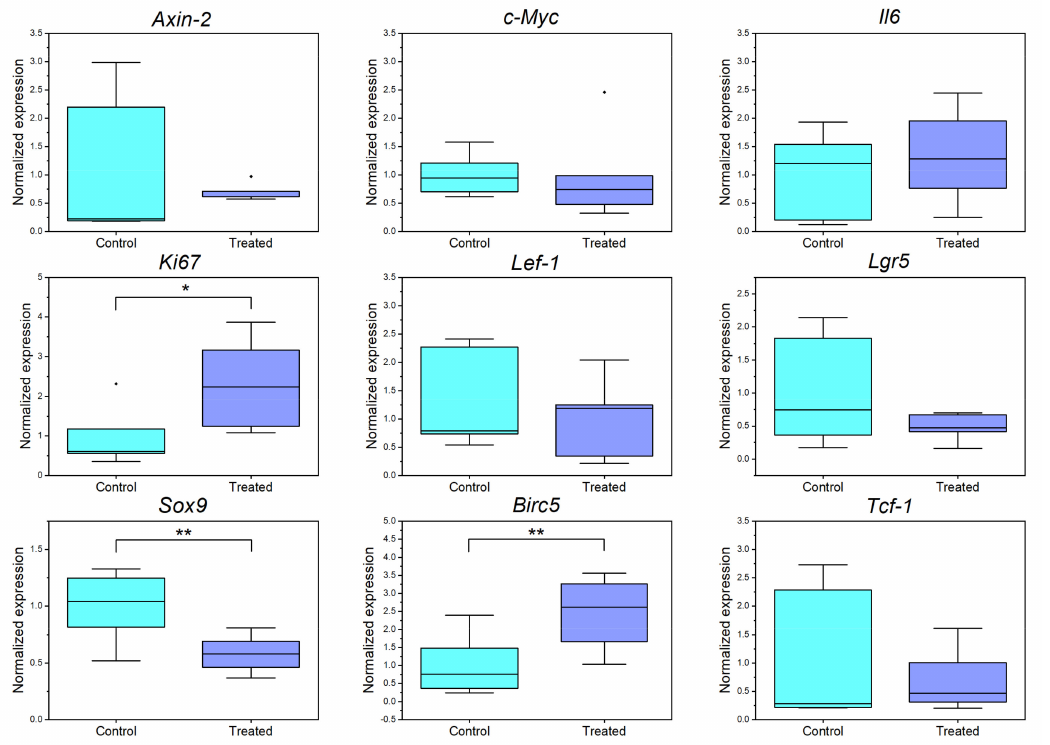
Figure 9. Box-plots of normalized gene expression levels of inflammatory ( Il6 ), Wnt -associated ( Axin-2, c-Myc, Lef-1, Sox9, Tcf-1 ), proliferation ( Ki67, Birc5 ), or stem cell associated genes ( Lgr5 ). Gene expressions were examined 5 h after laser ablation (4 h incubation at 37 ◦ C and 5% CO 2 , 1 h colonoid harvesting and lysing). A single cell from each crypt region of 30 colonoids was ablated. Thirty untreated colonoids per dish served as controls. A duplicate assay of three biological samples and two technical replicates was performed. The respective gene expression levels were related to the expression of the housekeepers Gapdh and β -actin . * p ≤ 0,05, ** p ≤